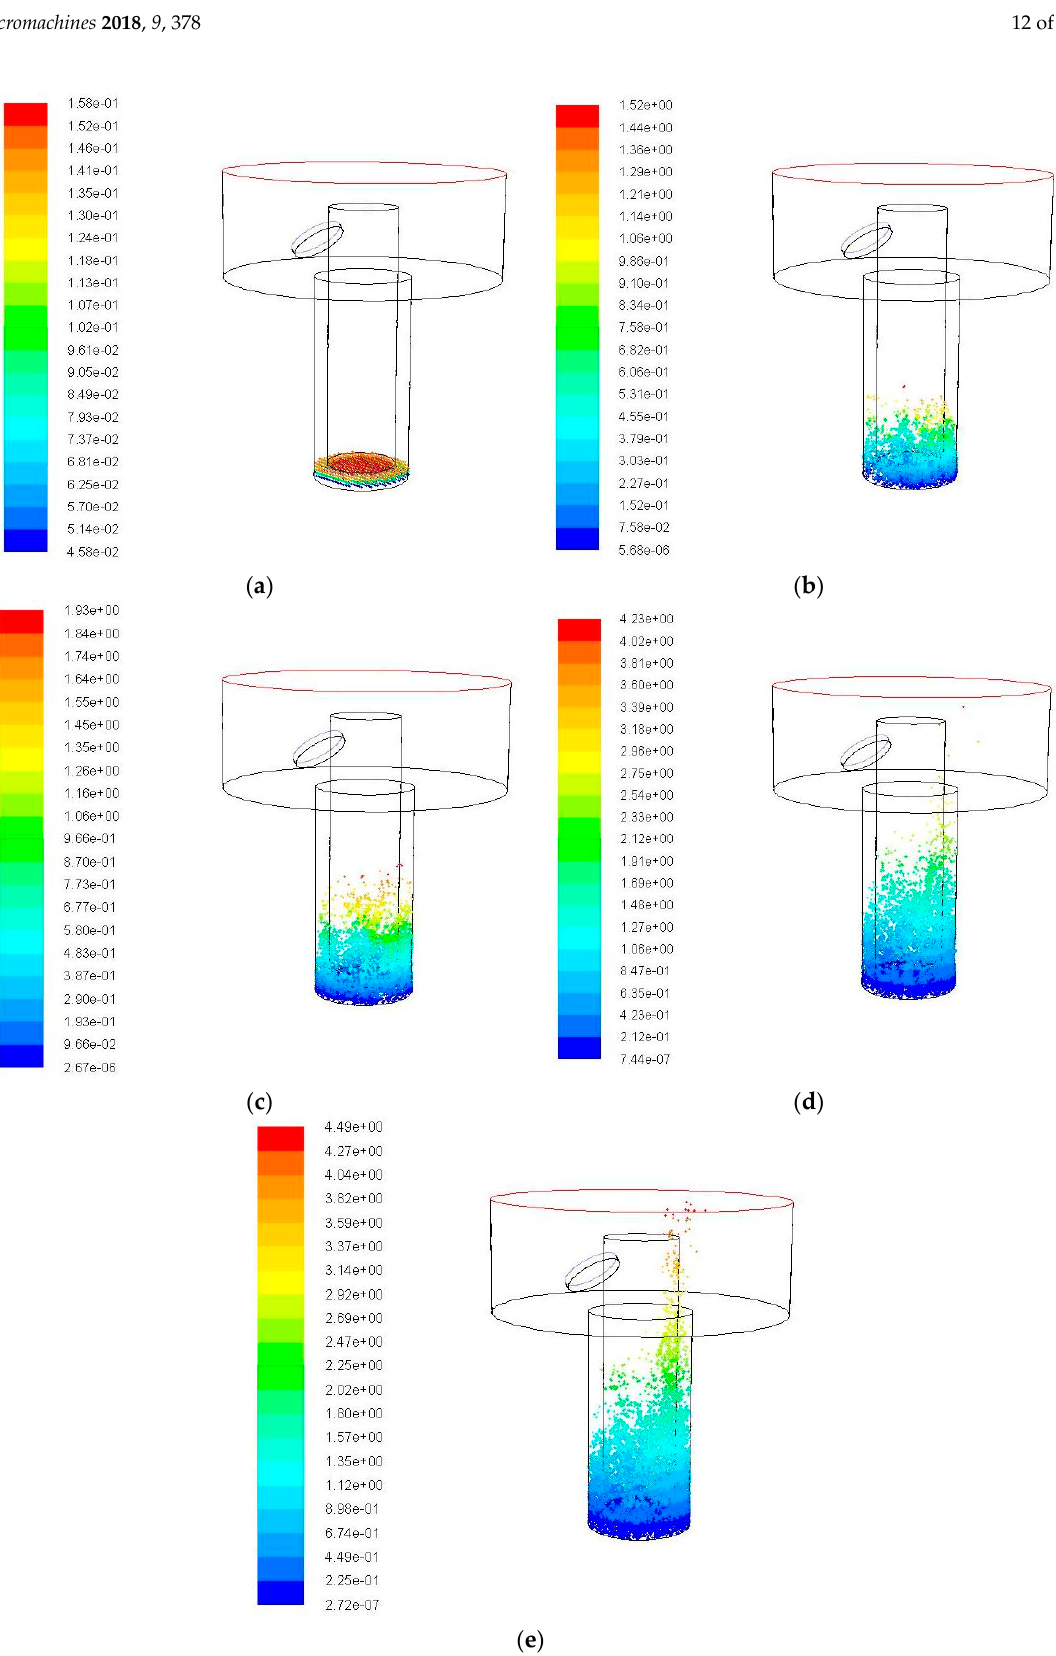
Figure 8. The debris movement with time when ultrasonic frequency is 20 kHz, amplitude is 20 μ m. ( a ) Initial debris distribution; ( b ) Debris distribution at 0.01 s; ( c ) Debris distribution at 0.02 s; ( d ) Debris distribution at 0.03 s; and, ( e ) Debris distribution at 0.04 s.